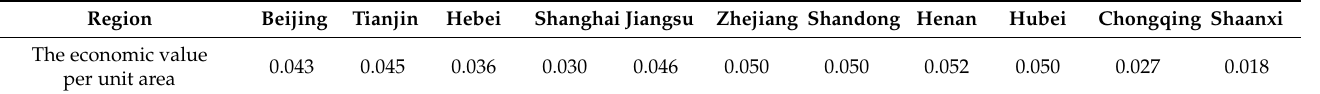
Table 1. Economic value of grain provided per unit area of each province/municipality directly under the central government (yuan/m 2